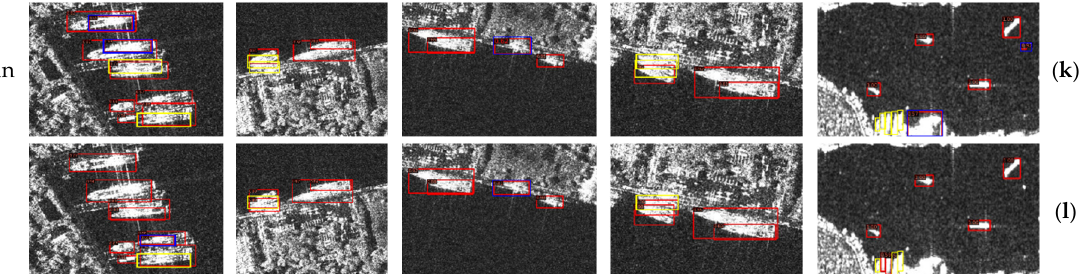
Figure 7. Experimental results for the SSDD dataset. ( a ): ground truth images; from ( b – l ): predicted results of Faster RCNN, YOLOv3, Cascade R-CNN, PAA, ATSS, DETR, Deformable DETR, Tood, YOLOF, Cascade R-CNN Swin, and ESTDNet, respectively. The ground truths, detection results, missed detection results and the false detection results are indicated with green, red, yellow, and blue boxes, respectively.